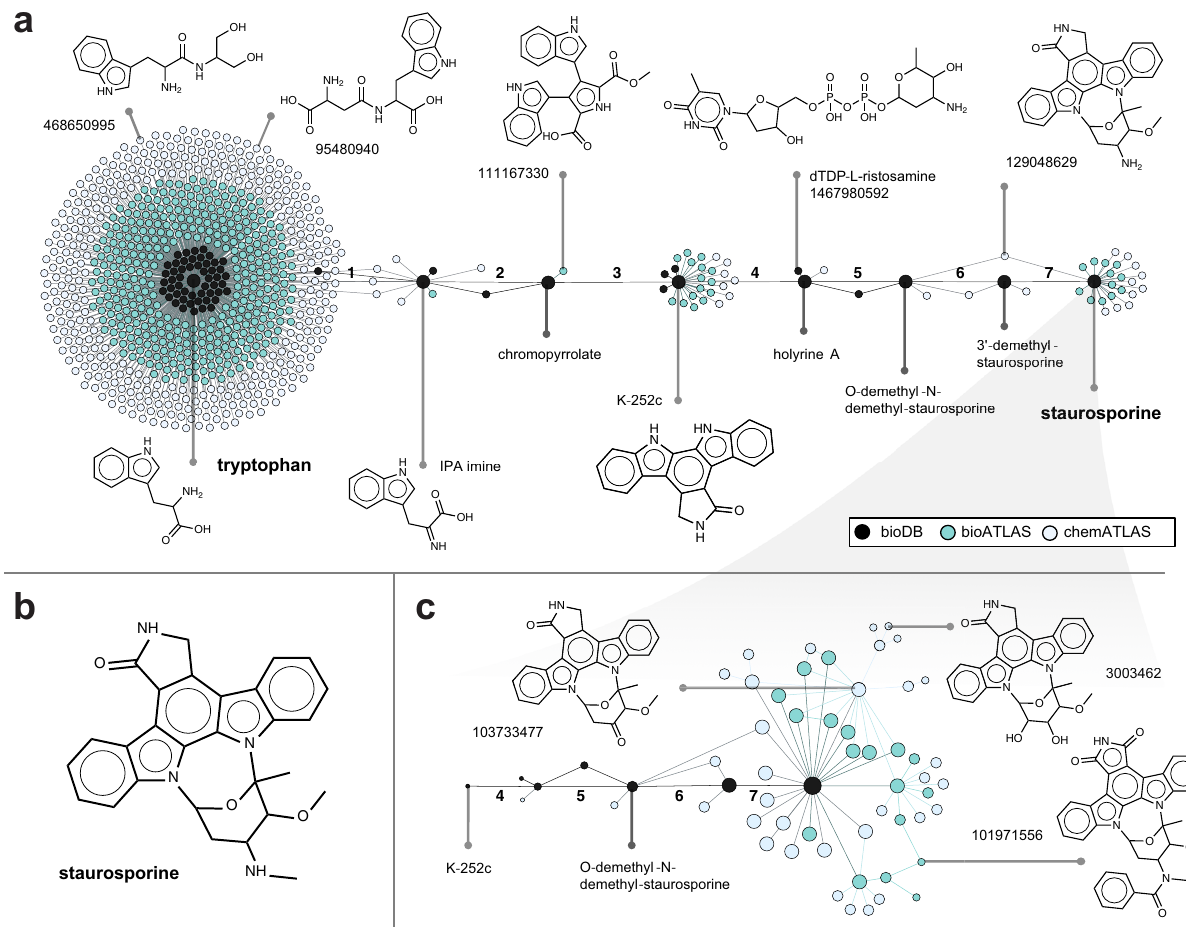
Fig. 4 Example pathway expansion showcase for the biosynthesis of the natural product staurosporine. a Visual representation of the biosynthesis pathway from tryptophan to staurosporine (obtained from KEGG, steps numbered in bold black) has been expanded for one generation around the native intermediates. b The molecular structure of staurosporine. c Network of potential staurosporine biochemistry expanded four generations around the target compound. The size of each compound nodes decreases with each generation. When no compound is indicated, the LCSB compound ID is